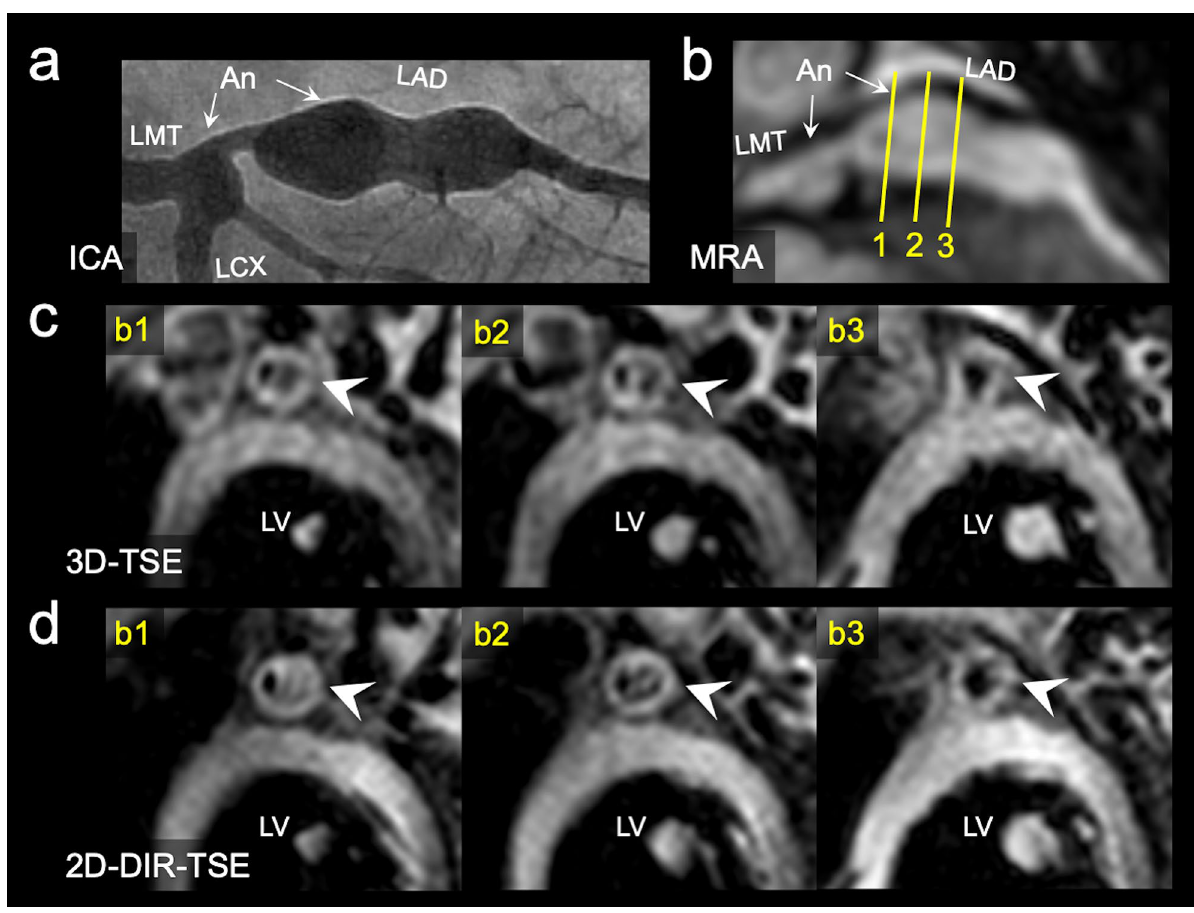
Figure 6. Invasive coronary angiography demonstrates two left coronary artery aneurysms (coronary artery segment 5, 4.5 mm; segment 6 to 7, 8.3 mm) in case 1 ( a ). In the MRA-collapsed partial MIP image, the yellow lines indicate aneurysmal regions ( b ). Each cross-sectional image of 3D-TSE and 2D-DIR-TSE corresponds to the solid line numbers in the MRA ( c,d ). In the 3D-TSE and 2D-DIR-TSE images, intraluminal signals in the aneurysm mimic thrombi because the flow signals are not suppressed. In the cross-section indicated by b2, the visual grading of the lumen boundary and outer wall boundary in 3D-TSE and 2D-DIR-TSE images have been grades 2 and 4, respectively, and depicted equally (arrowheads in ( c,d )) ( An aneurysm, LMT left main trunk, LAD left anterior descending artery, LCX left circumflex artery, LV left